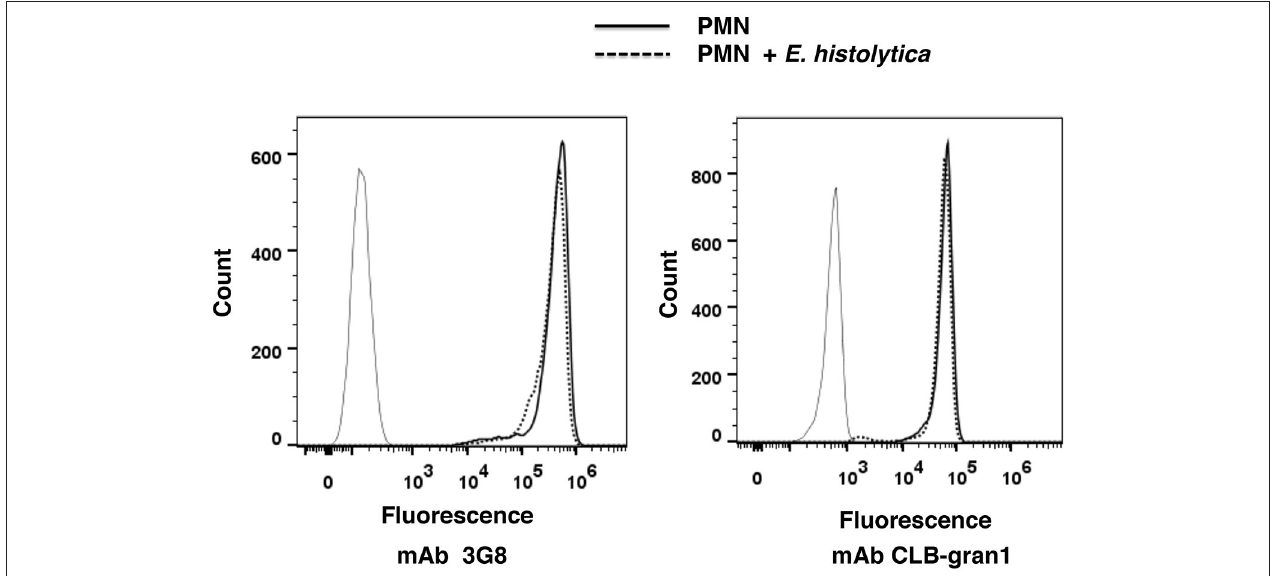
FIGURE 6 | Entamoeba histolytica trophozoites did not change surface expression of receptor Fc γ RIIIb (CD16b). Human neutrophils were not stimulated (solid line) or were stimulated with E. histolytica trophozoites (dashed line) for 30min at 37 ◦ C. Then, cells were fluorescence-stained with secondary antibody only (thin line), or with monoclonal antibody (mAb) 3G8 or with mAb CLB-gran1, both specific against Fc γ RIIIb, as described in section Materials and Methods. Fluorescence intensity was then analyzed by flow cytometry. Histograms are representative of three independent determinations.